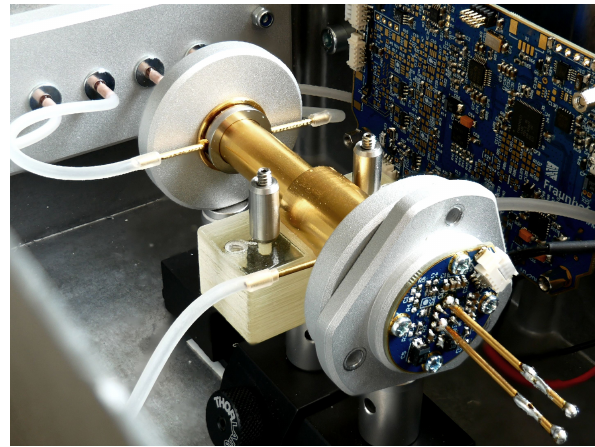
Figure 7. The realized three-chamber-based photoacoustic